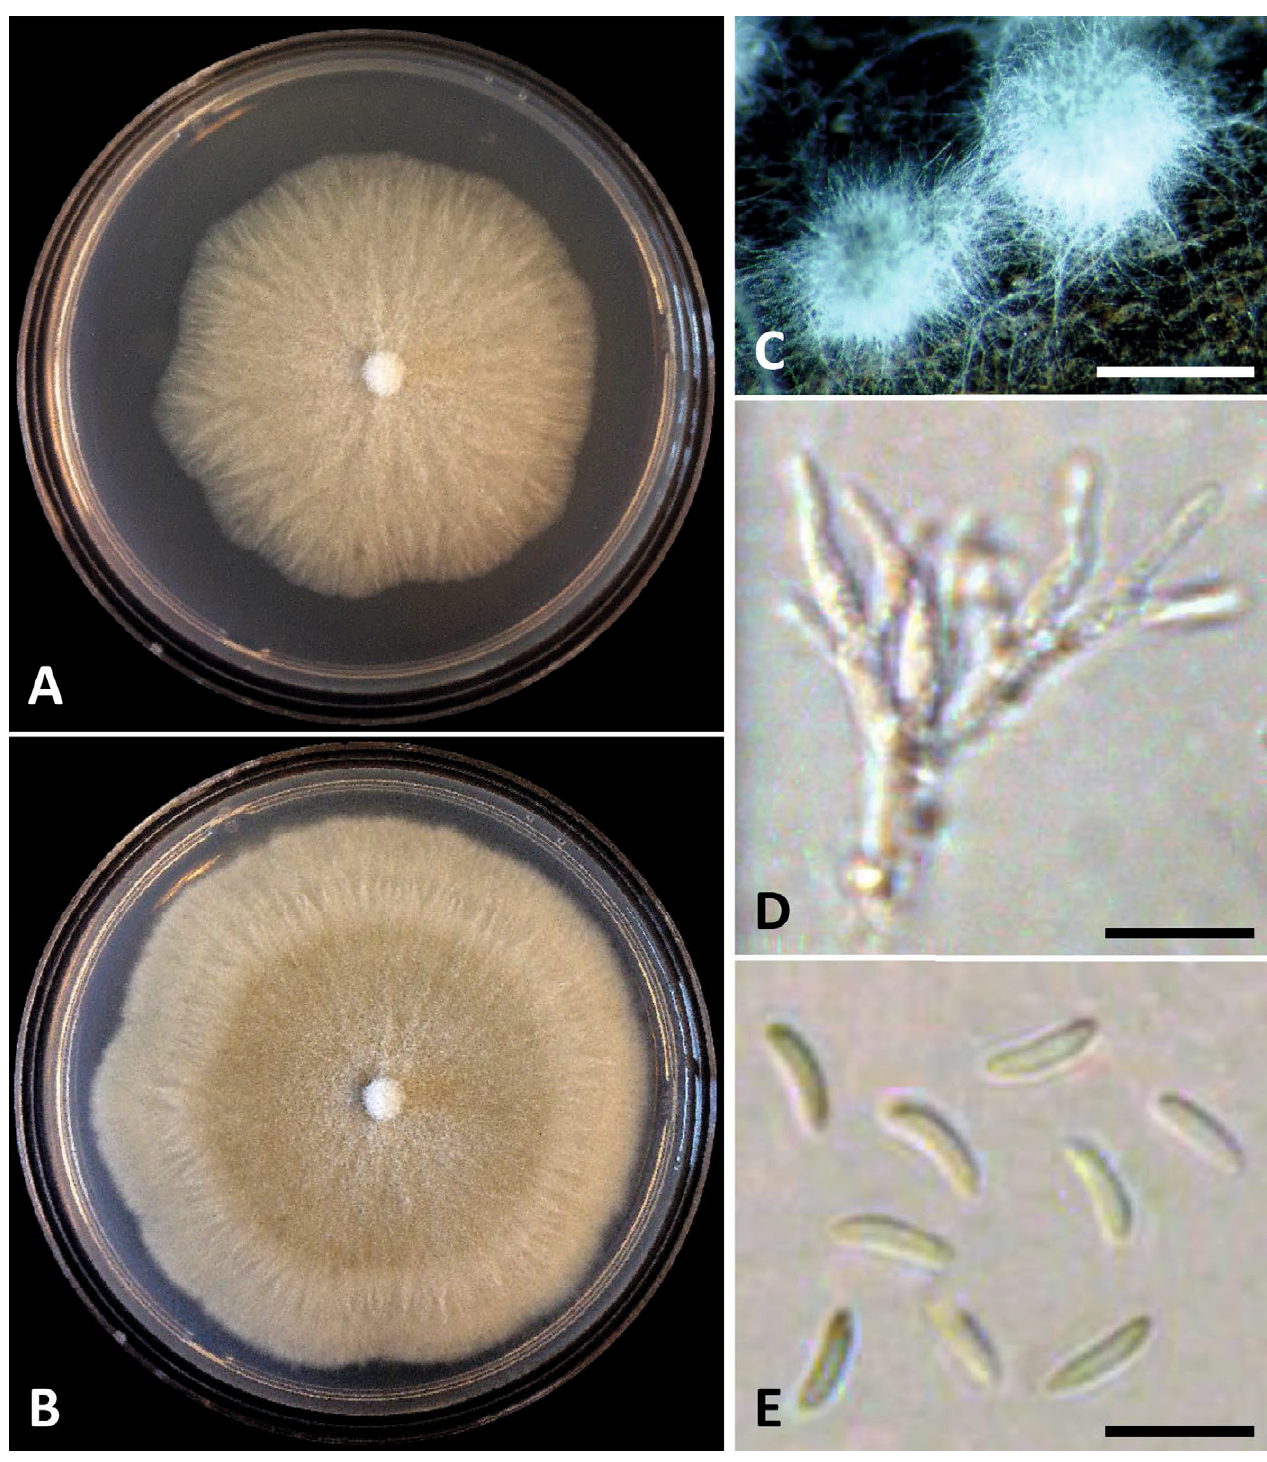
Fig. 6. Cytospora californica (ex-holotype culture CBS 144234). A. Seven-day-old PDA culture. B. Fourteen-day-old PDA culture. C. Pycnidia. D. (cid:2){(cid:4)(cid:17)(cid:11)(cid:21)(cid:11)(cid:4)(cid:18)(cid:14)(cid:4)(cid:10)(cid:13)(cid:7)(cid:2)(cid:9)(cid:17)(cid:21)(cid:2)(cid:20)(cid:23)(cid:9)(cid:6)(cid:13)(cid:17)(cid:8)(cid:4)(cid:5)(cid:7)(cid:2)(cid:19)(cid:4)(cid:17)(cid:11)(cid:21)(cid:11)(cid:4)(cid:25)(cid:13)(cid:17)(cid:4)(cid:5)(cid:7)(cid:2)(cid:19)(cid:13)(cid:23)(cid:23)(cid:7)(cid:28)(cid:2) E. Conidia. Bars C = 1 mm; D = 10 μm; E = 5